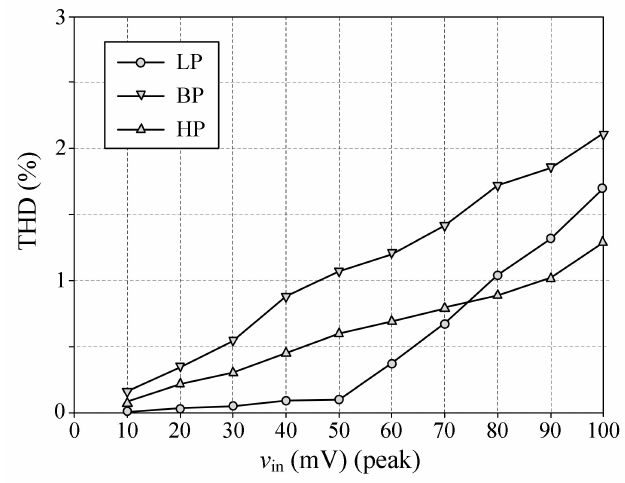
Figure 9. THD variations of the LP, BP, and HP output waveforms in VM.